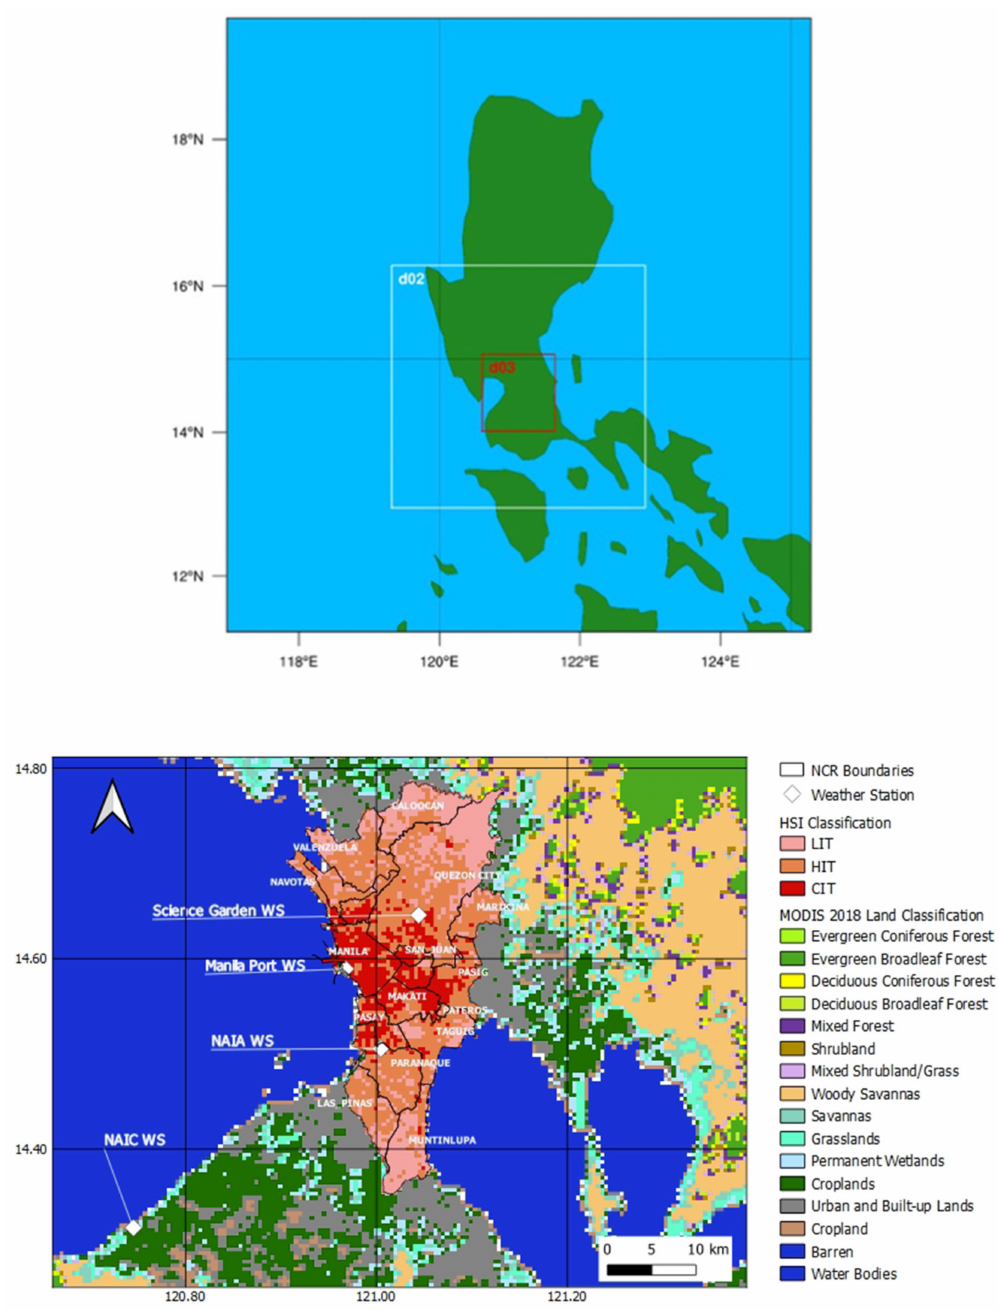
Figure 1. Map of the study area showing WRF domains ( top ) and the cities of Metro Manila, Human Settlement Index (HSI) classifications, weather stations (WS), and land cover classifications outside Metro Manila ( bottom ) based on MODIS land use/land cover